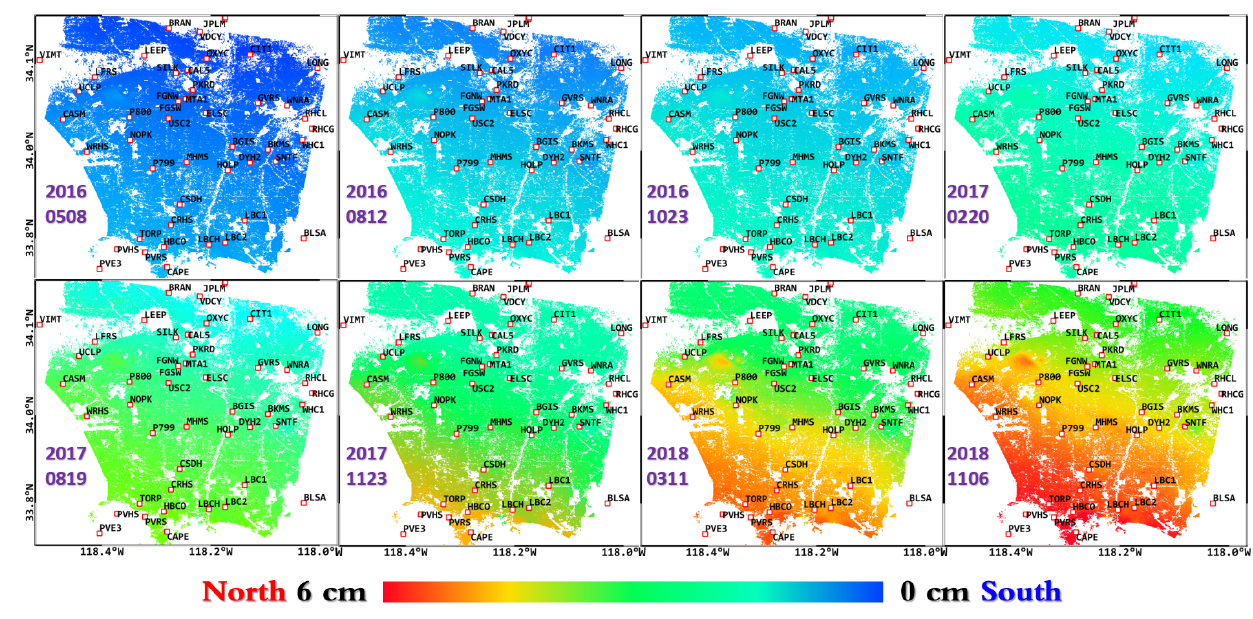
Figure 10. North–south deformation time series maps obtained by SM-Kalman. GNSS sites are represented by red boxes.